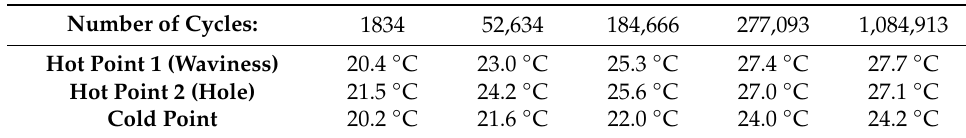
Table 3. Surface temperature for control points of the specimen cut in transversal direction with geometry A.